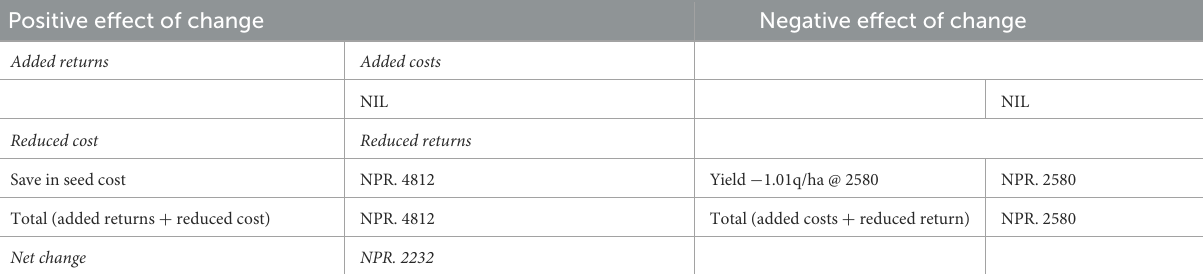
TABLE 5 Scenario 3: partial budget of RH-10 for winter